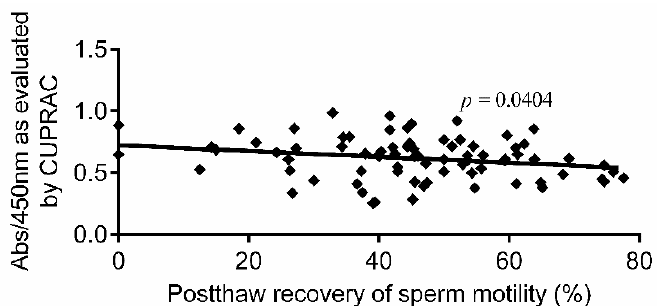
Figure 1. Correlation between post-thaw recovery of sperm motility and absorbance at 450 nm, as evaluated by the cupric ion-reducing antioxidant capacity (CUPRAC) method ( n = 77). Abs: absorbance.